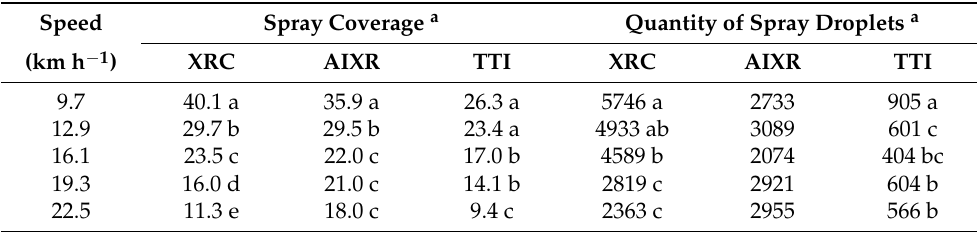
Table 4. Influence of ground speed on spray coverage (%) and quantity of spray droplets by nozzle type for CNS. CNS represents the sprayer without a rate controller used in this study.